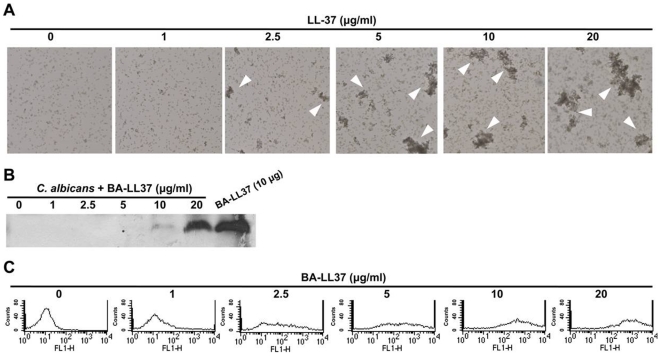
LL-37-induced C. albicans cell aggregation and LL-37 binding to C. albicans.(A) Visualization by microscopy of C. albicans cell aggregation after LL-37 treatment. C. albicans cells were incubated with LL-37 in RPMI-1640, and the floating cells were then injected into μ-Slides and visualized by microscopy (250× magnification). Cell aggregates are indicated by the arrowheads. (B) Western blot showing that LL-37 bound to floating C. albicans cells. C. albicans were incubated with BA-LL37 in RPMI-1640, and the contents of the floating cells were subjected to Tricine SDS-PAGE, blotted, and detected with SA-HRP. BA-LL37 (10 µg) served as the positive control. (C) Flow cytometry showing that LL-37 bound to C. albicans cells. Various concentrations of BA-LL37 were incubated with C. albicans in PBS at 4°C overnight, and then the levels of cell-bound BA-LL37 were assessed by flow cytometry that used SA-DTAF for detection. The data shown are representative of two additional independent experiments. FL1-H means the extent of fluorescence intensity.